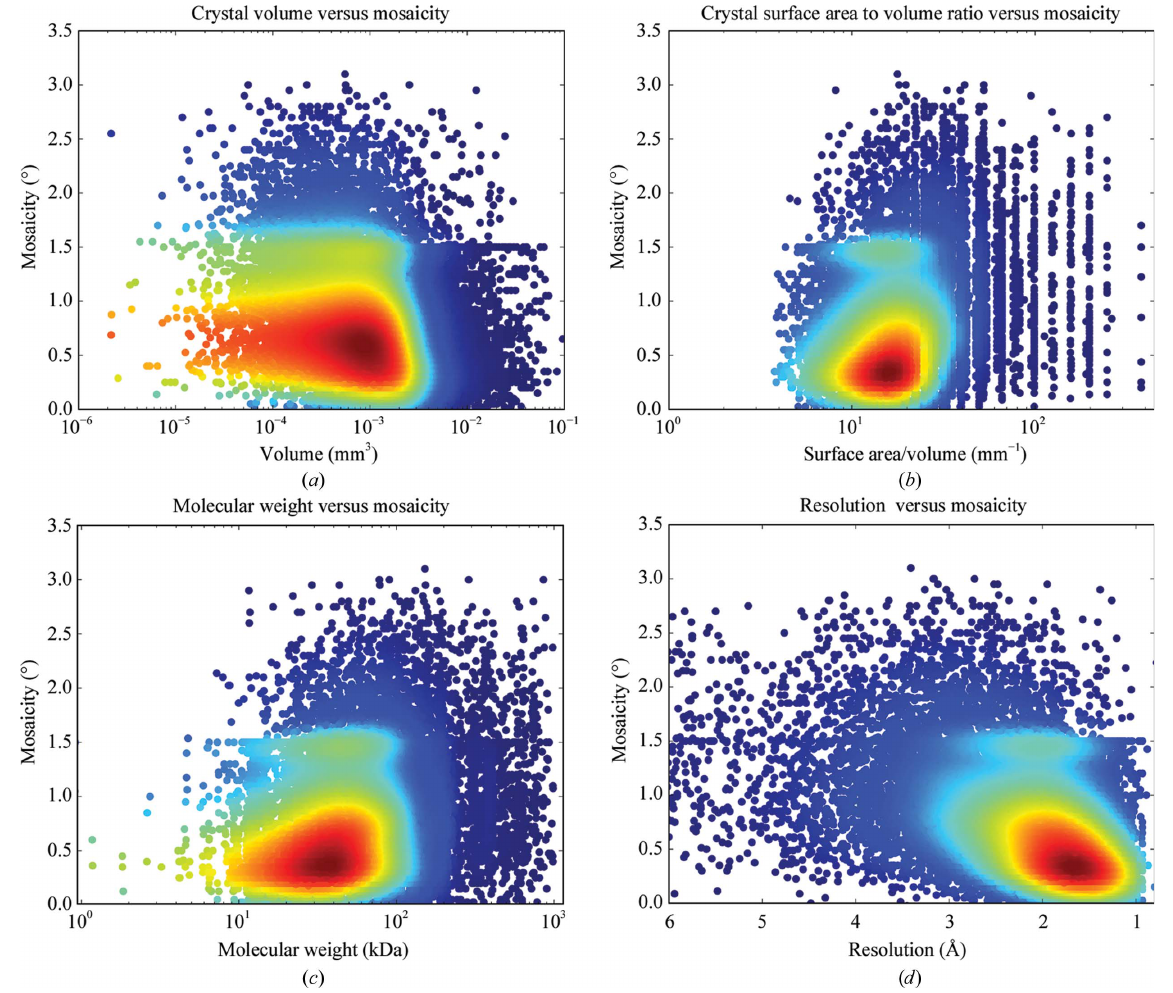
Figure 3 What parameters correlate with mosaic spread? Mosaic spread values are plotted against crystal volume, Spearman R = (cid:4) 0.26 ( a ), surface-area-to- volume ratio, Spearman R = 0.23 ( b ), molecular weight of the entity crystallized, Spearman R = 0.2 ( c ), and the resolution cutoff of the processed data set, Spearman R = 0.44 ( d ). Data points are coloured by KDE; N = 14 234 for each